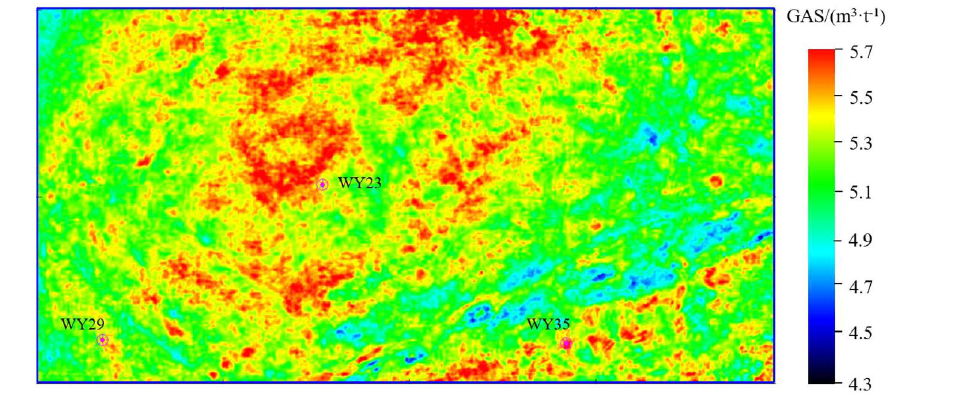
Figure 16. GAS distribution of the target reservoir